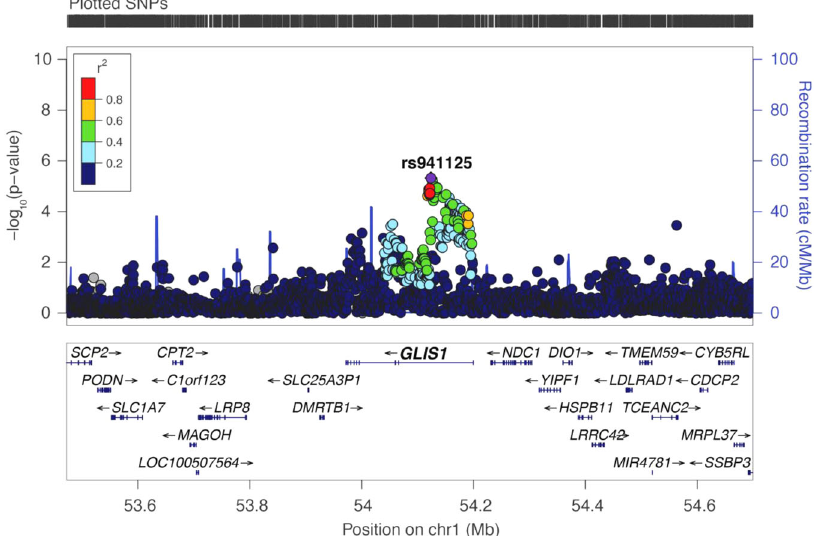
Fig. 7 Regional plot at the GLIS1 genomic region showing association with glaucoma in the combined (GERA + UK Biobank) multiethnic meta-analysis. Top SNP rs941125 is signi fi cantly associated with glaucoma after Bonferroni correction ( p = 4.73 × 10 − 6